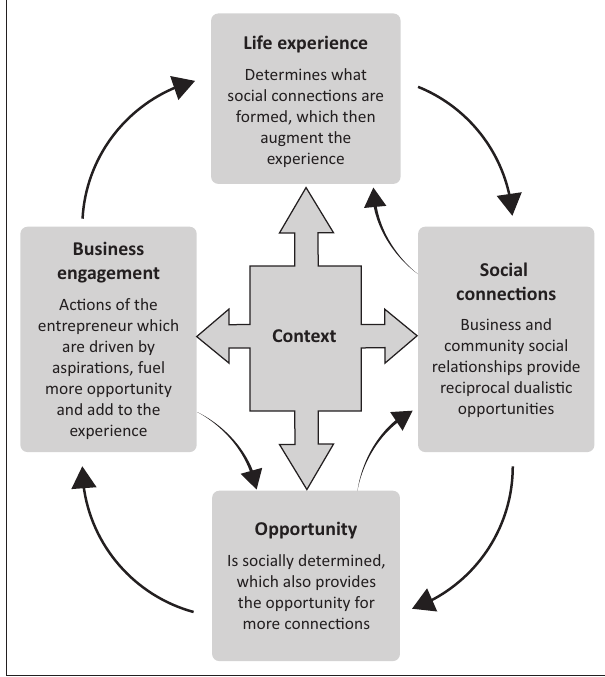
FIGURE 2: A visual representation of how opportunity, contextualised in poverty, was socially